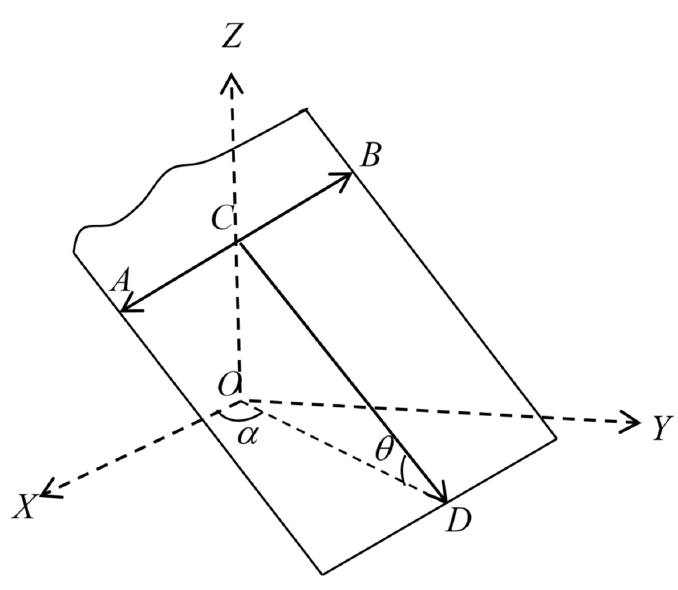
Figure 4. Spatial state of fractures.